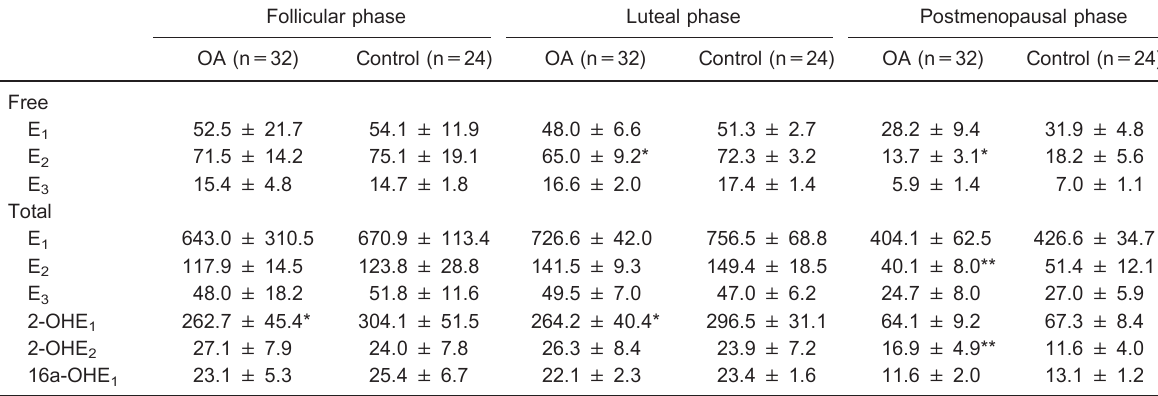
Table 4. Serum free (unconjugated) and total (conjugated ++ unconjugated) levels of selected estrogen metabolites in the follicular, luteal, and postmenopausal phases in women with OA and healthy